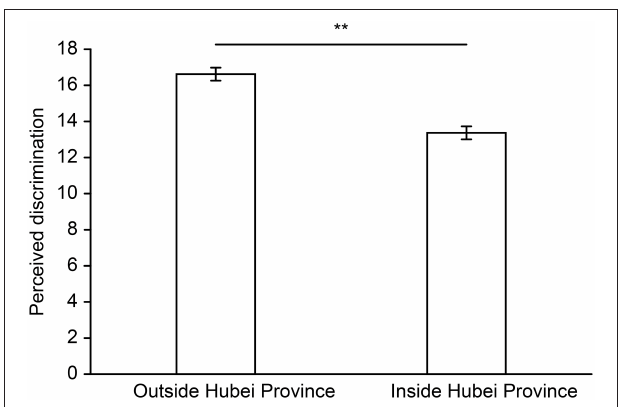
FIGURE 1 | Perceived discrimination by hometown address (error bars show ± 1 SEM, ** p < 0.01).